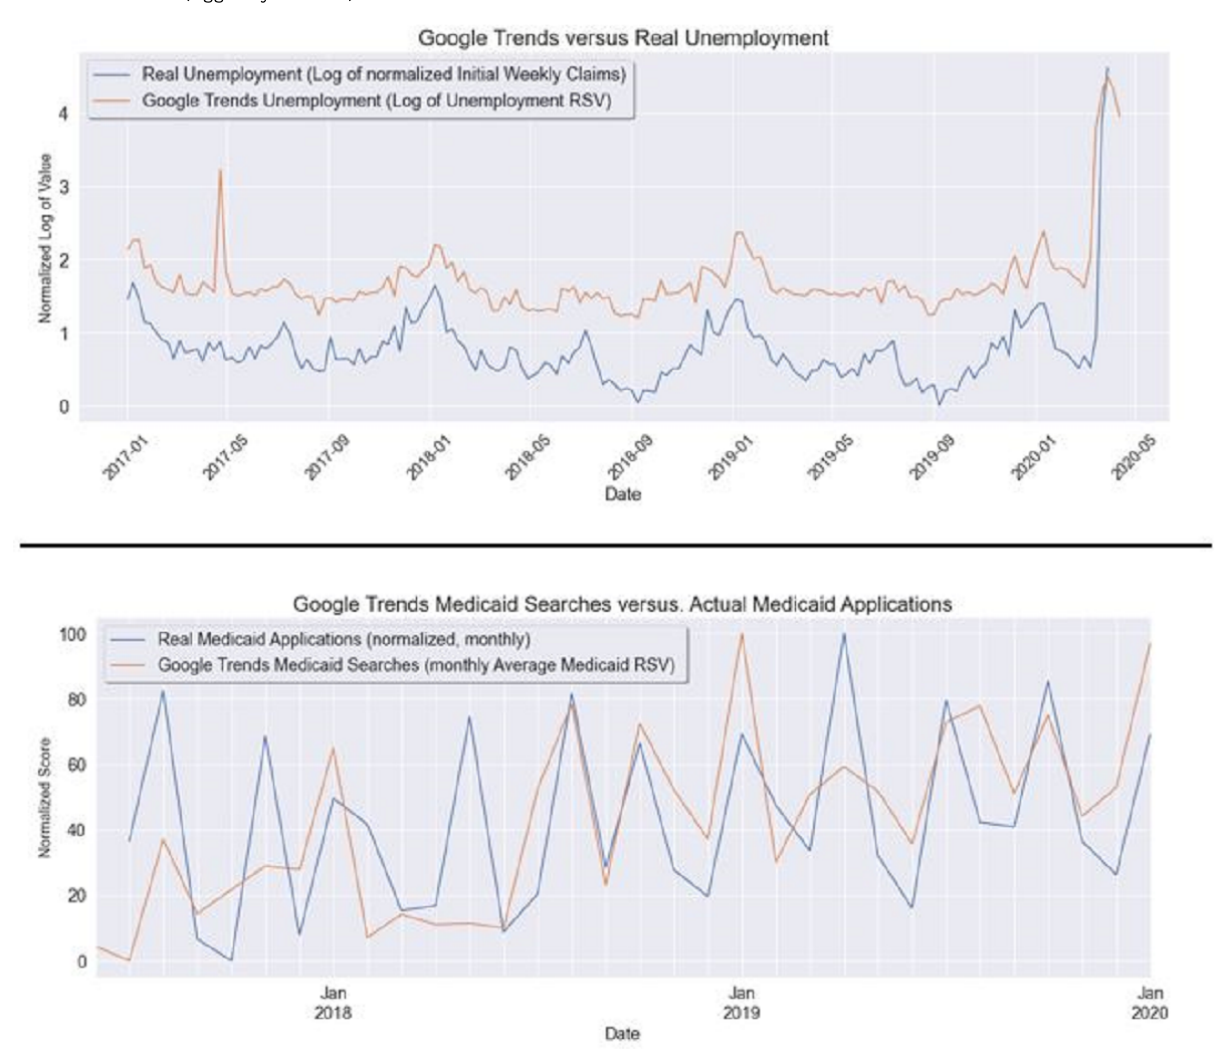
Figure 3. National-level multivariate trends for new weekly unemployment (January 2016 to April 2020) [39] and new monthly Medicaid applications (July 2017 to January 2020) [38]. Top: Google searches for unemployment applications and actual initial weekly unemployment claims normalized from 0-100 over time (with seasonal adjustment). Bottom: Monthly average Google searches for Medicaid and actual new applications for Medicaid normalized from 0-100 (lagged by 1 month). RSV: relative search